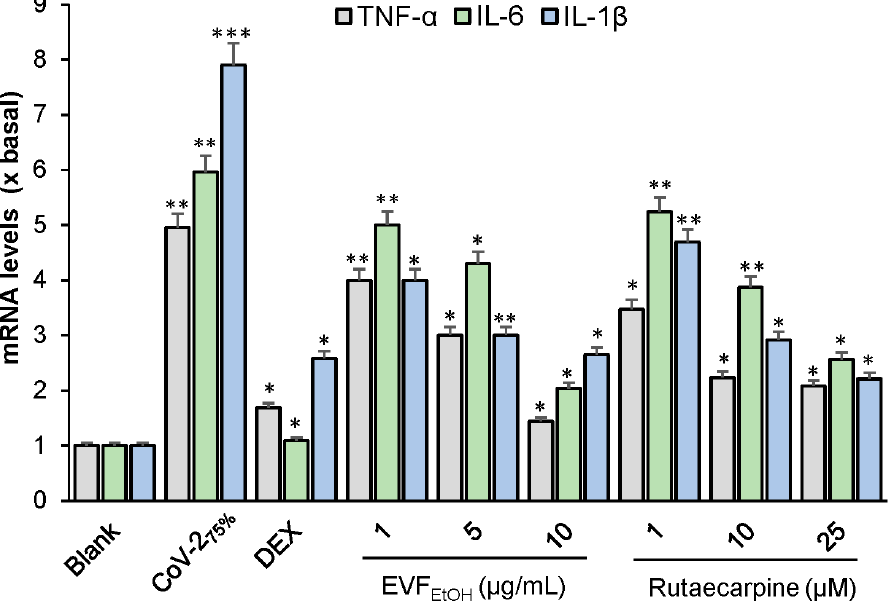
Figure 8. EVF EtOH and rutaecarpine suppress SARS-CoV-2-induced inflammation in cultured macrophages. The mRNA levels of the inflammatory cytokines TNF- α , IL-6, and IL-1 β , were measured by RT-PCR. The data indicate the mean ± SD ( n = 5) fold change against the blank group (x basal), and the asterisks indicate statistically significant differences such that * p < 0.05, ** p < 0.01, *** p < 0.001 compared with the blank group.